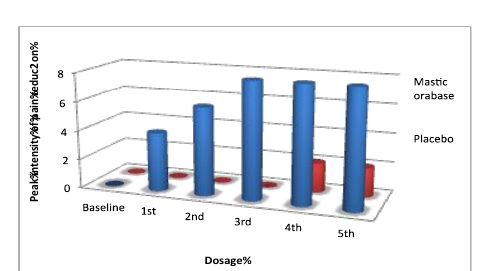
Fig. 4: The peak intensity of pain reduction with the dosage of mastic orabase and placebo groups. {(0= Baseline severe pain, 2= Moderate, 4= Mild, 6= Minimal, 8= No pain), Dose No. was 5 minutes between each}.